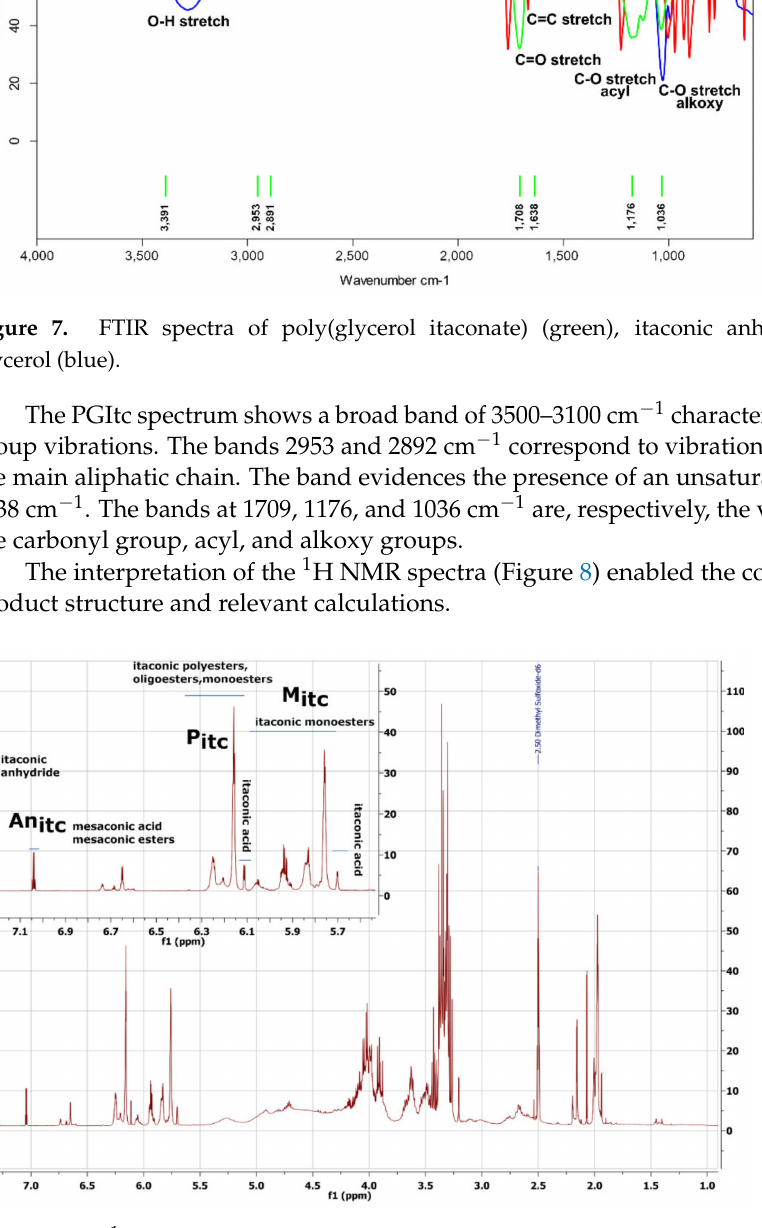
Figure 8. The 1 H NMR spectra of poly(glycerol